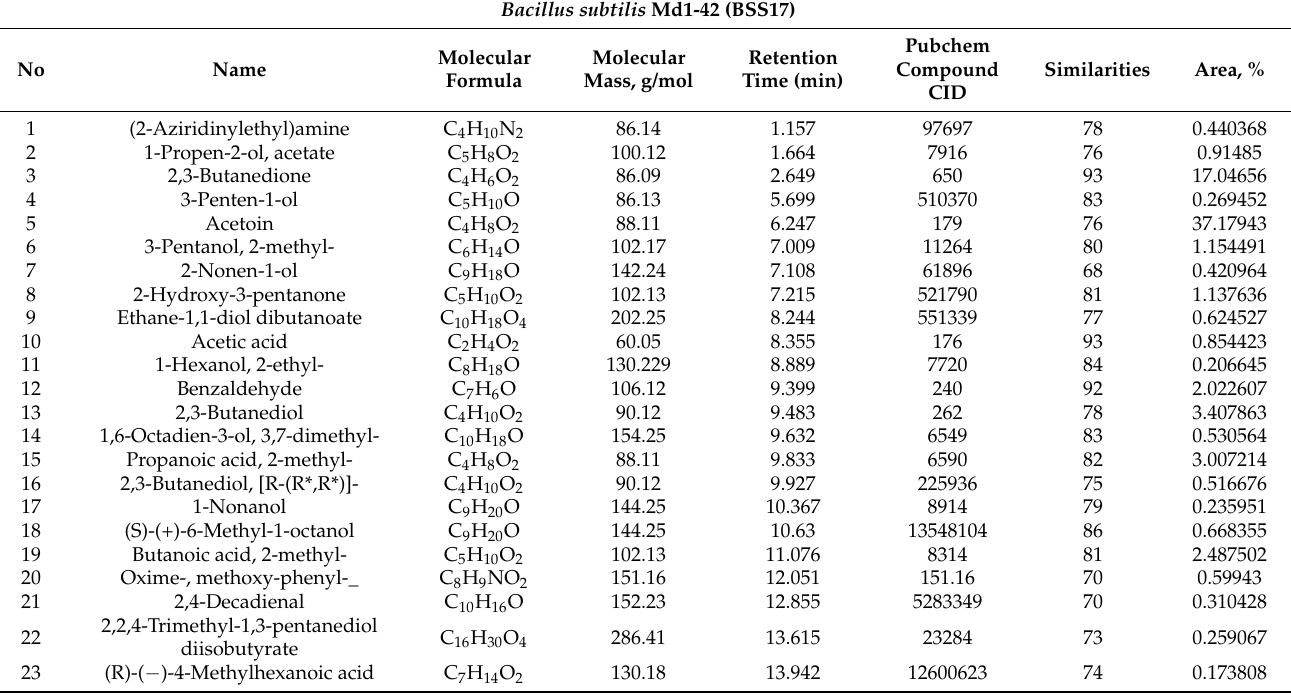
Table 5. The main constituents of bacterial extract BSS17 identified through a GC–MS